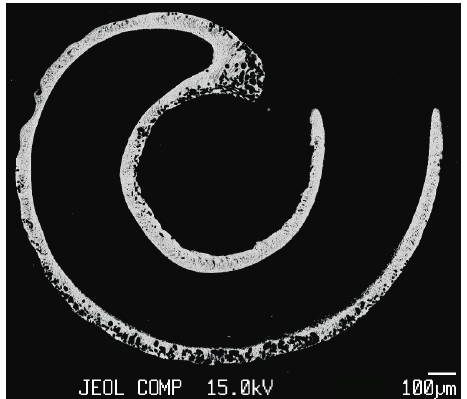
Figure 11. SEM image (BEI) of polished cross section of S. spiror- bis shell from summer control experiment. Dark spots are micro- borings mostly affecting the outer tube wall.